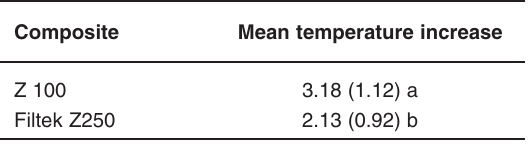
Different letters indicate statistically significant difference (Tukey’s test, p<0.05). Standard deviations are given in parentheses.